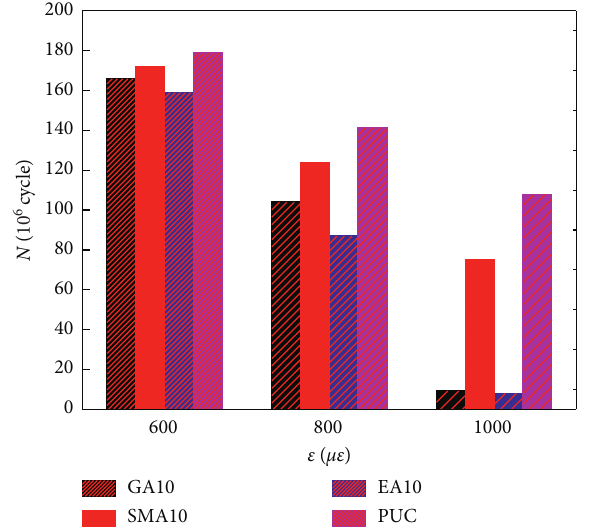
Figure 16: Fatigue life comparison of polyurethane cement and asphalt